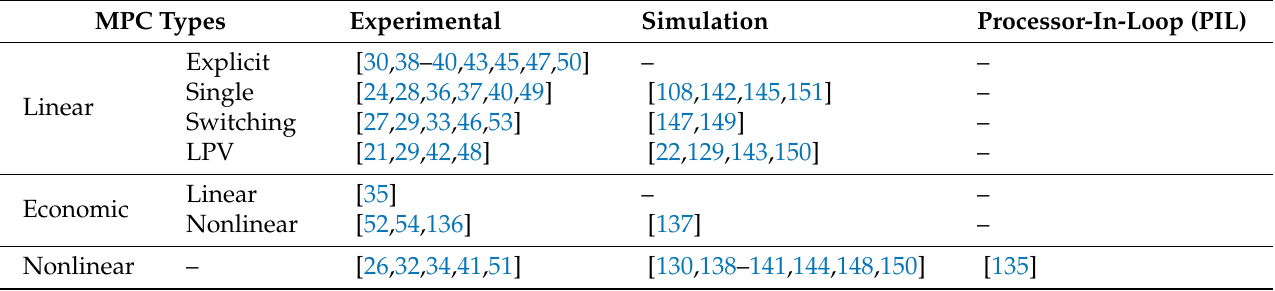
Table 1. Types of MPC controllers used in the literature that are demonstrated for ICE